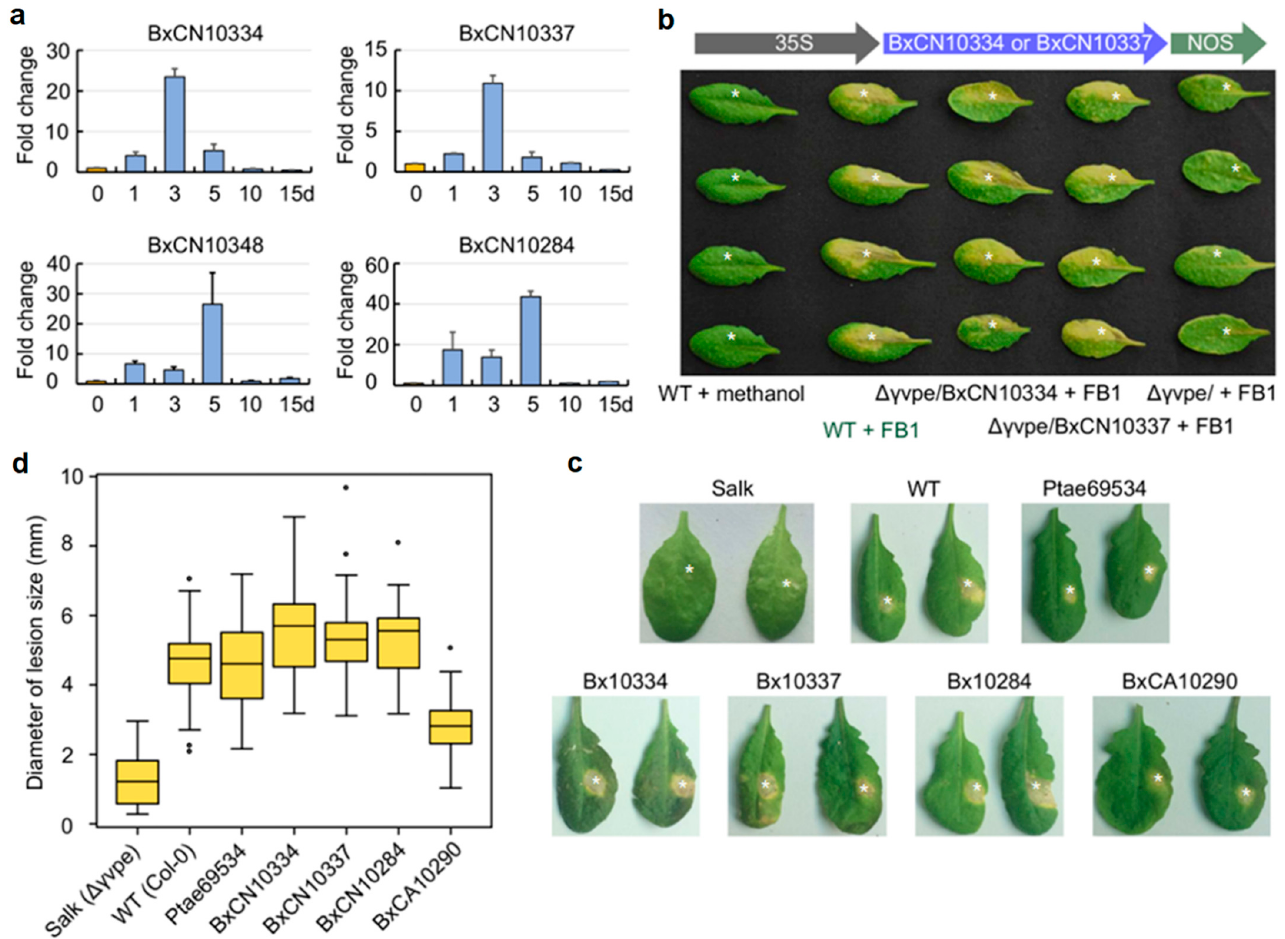
Figure 4. Expression patterns and functional complementation assay of B. xylophilus –specific legumains: ( a ) RT-qPCR detection of mRNA expression of B. xylophilus -specific legumains after the nematode was inoculated on five years old pine seedlings ( P. thunbergii ) for 1 to 15 days, taking 0 d (1–2 h) as control. The EF-1 α gene was used as an internal control. Bars are standard errors (SE); ( b ) two BxCN legumain genes (BxCN10334, BxCN10337) were introduced into the Arabidopsis ∆ γ vpe mutant (Salk_024036C). Necrotic spots are observed on leaves of homozygous T3 plants after infiltration with FB1 (10 mM, in 0.1% methanol) for five days, which are similar to those in the wild type Arabidopsis plants infiltration with FB1. The mutant plants infiltrated with FB1 and the wild type plants infiltrated with methanol (solvent) are taken as controls; ( c ) quantitative assay of complementation effects of transgenic lines with four B. xylophilus -specific legumains and a pine VPE ( Pinus taeda PITA_000069534), by infiltration with 10 µ L of FB1 (in 0.1% methanol) on each leaf. Necrotic lesions on ∆ γ vpe mutant and the wild type Arabidopsis plants are taken as controls; ( d ) comparison of the mean diameters of necrotic spots in different transgenic lines and the wild-type Arabidopsis plants, compared with the ∆ γ vpe mutant. Black dots represent